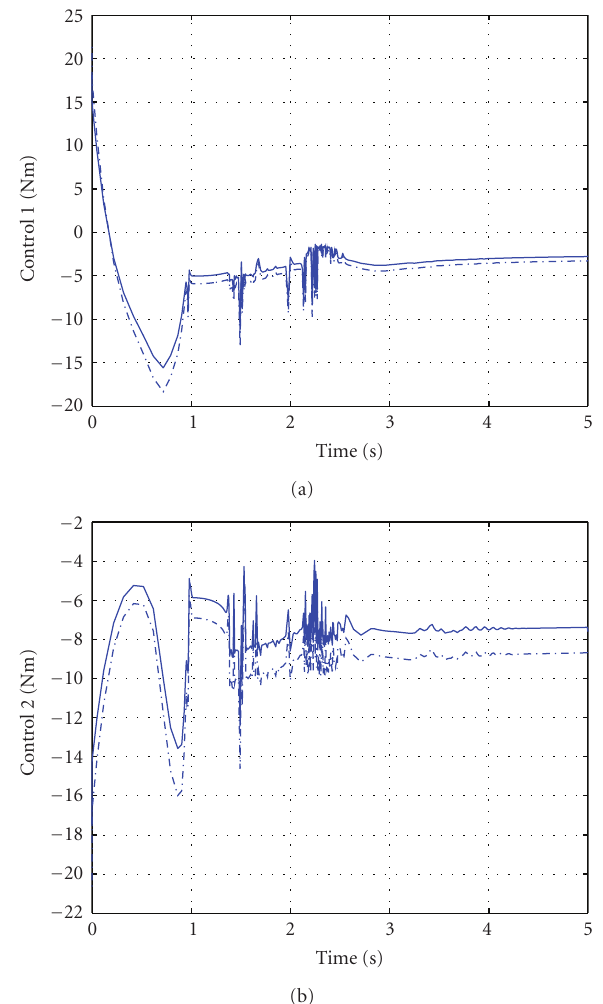
Figure 10: Comparative plots for control inputs of both joints between the controller [14] (.–) and our proposed controller